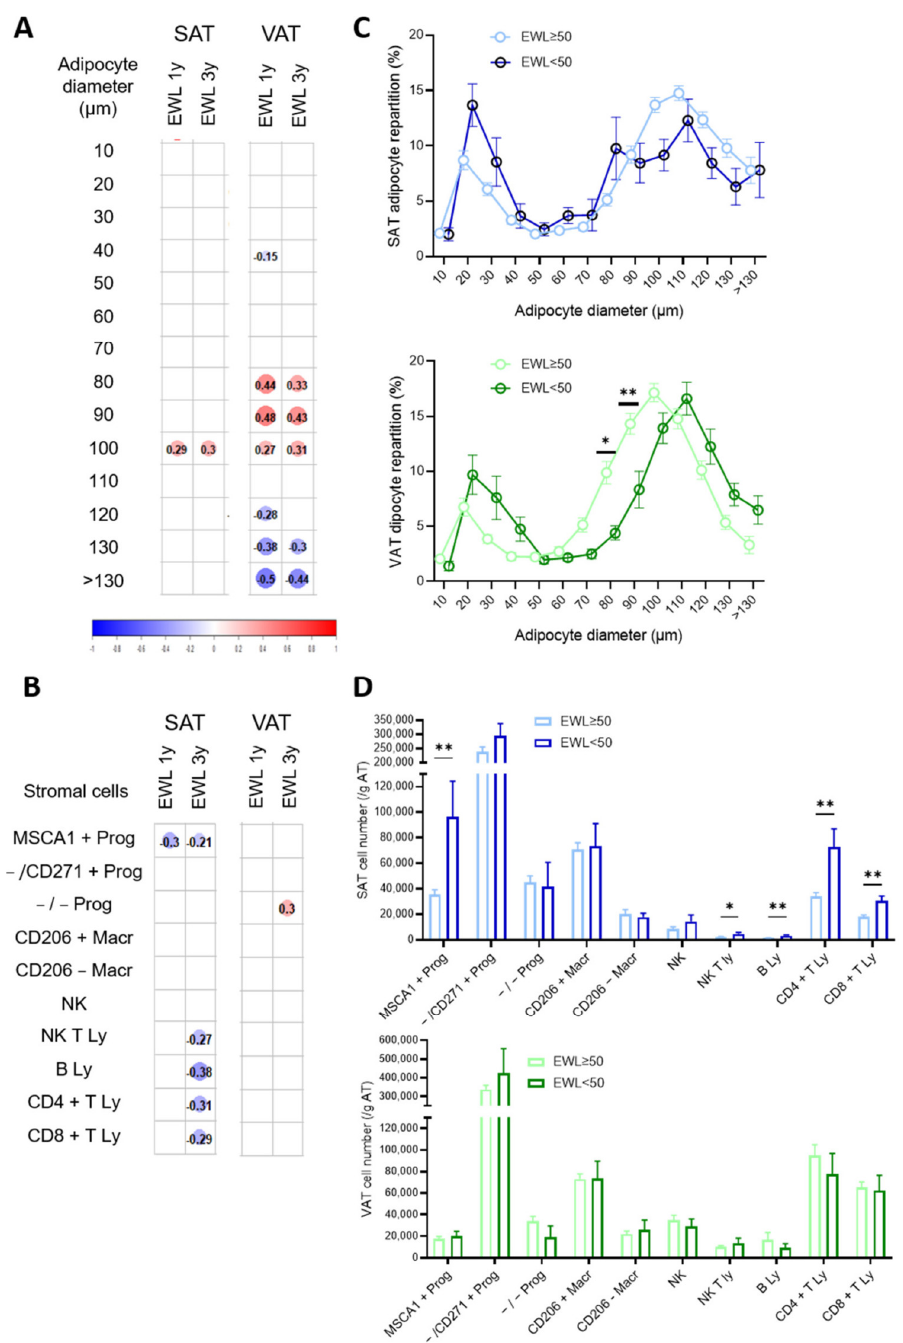
Figure 3. Cell phenotypes of expanded SAT and VAT associated with excess weight loss after BS. Correlation matrix between ( A ) adipocyte diameter repartition (%) in SAT and VAT or ( B ) stromal cell numbers in SAT and VAT prior bariatric surgery and excess weight loss (EWL) one year (1y) and three years (3y) post-surgery. Spearman correlations with p < 0.05 are shown with Spearman r value indicated in the color circle for n = 101 and n = 60 for adipocyte diameters at 1 year and 3 years, respectively, and n = 134 and n = 70 for stromal cells at 1 year and 3 years, respectively. ( C ) Adipocyte diameter repartition in SAT (blue) and VAT (green) of patients with EWL more or less than 50% three years post-surgery. Values are means ± SEM of n = 47 patients with EWL more than 50 and n = 9 with less than 50, two-way ANOVA followed by Sidak multiple comparisons test, *, p < 0.05, **, p < 0.01. ( D ) Stromal cell numbers determined by flow cytometry analyses in SAT (blue) and VAT (green) of patients with EWL more or less than 50% three years post-surgery. Values are means ±